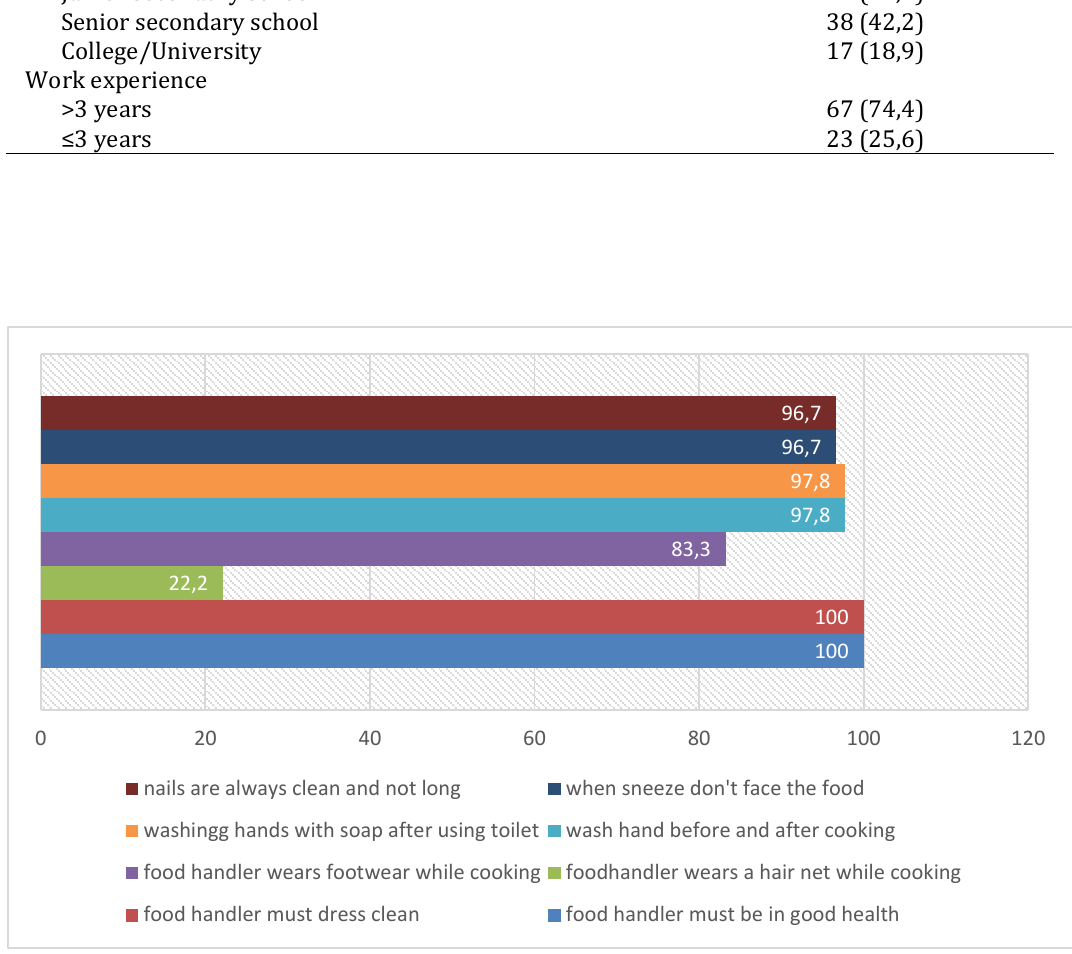
Figure 1. Hygiene practice of food